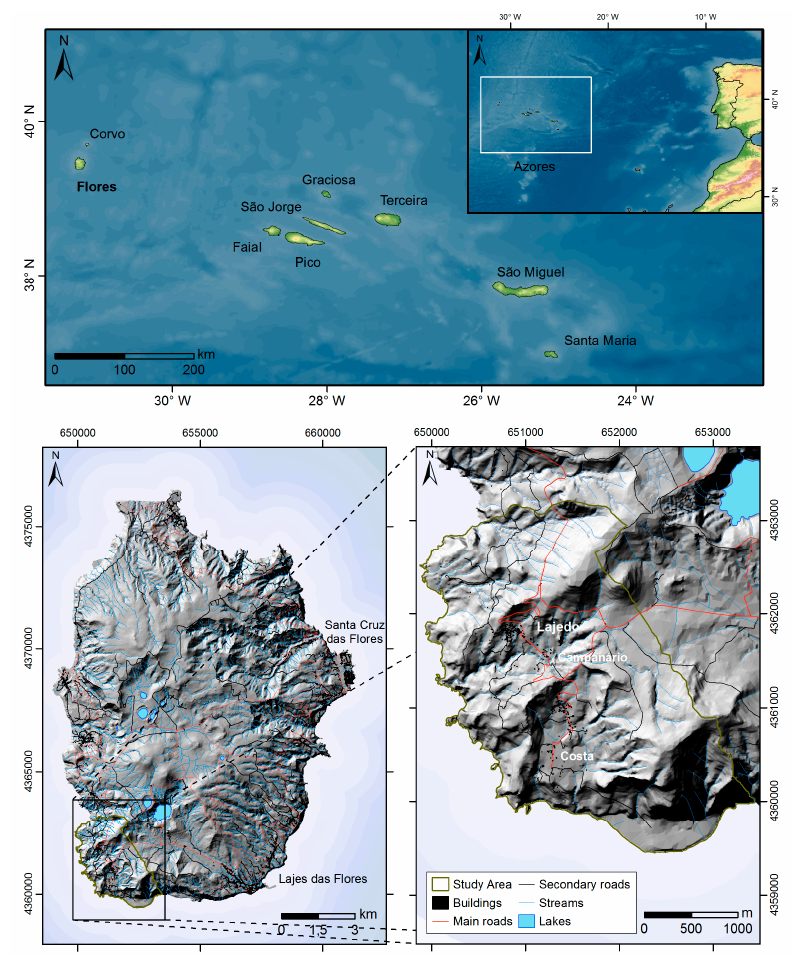
Figure 1. Location of the study area on Flores Island in the Azores archipelago.